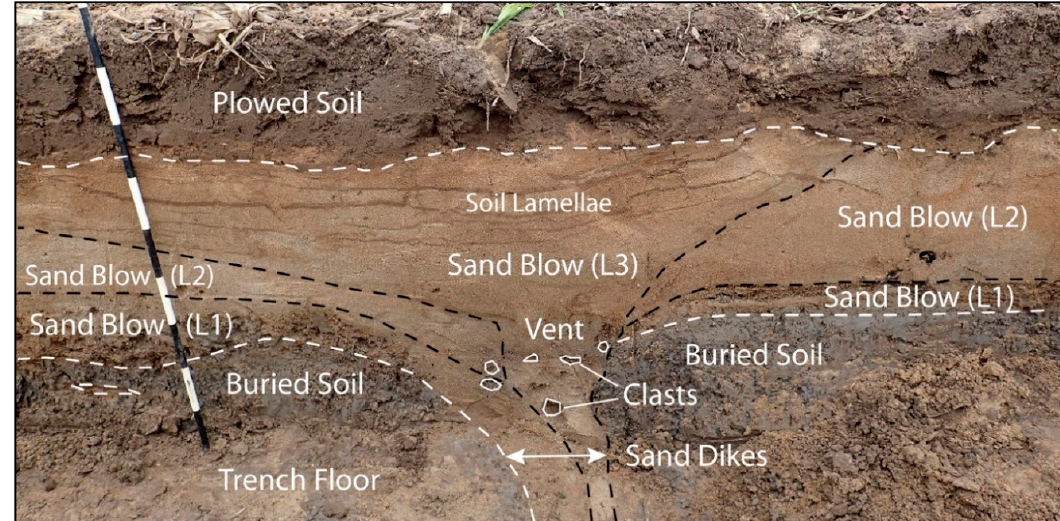
Figure 28. Example of a compound sand blow composed of three depositional units (L1, L2, and L3) and related feeder dikes that formed during three earthquakes in a sequence [8]. Radiocarbon dating of the buried soil immediately below the sand blow provides close maximum calibrated date of before Christ (BC) 1010. Note the soil lamellae in the sand blow which takes hundreds to thousands of years to form. Dashed lines represent contacts. Black and white intervals on meter stick are 10 cm long. On the basis of the age estimates of the paleoliquefaction features, large paleoearthquakes are estimated to have occurred in the NMSZ in AD 1450 ± 150 years, AD 900 ± 100 years, AD 0 ± 200 years, before Christ (BC) 1050 ± 250 years, and 2350 BC ± 200 years (Figure 29) [6–8]. The AD 1450 and AD 900